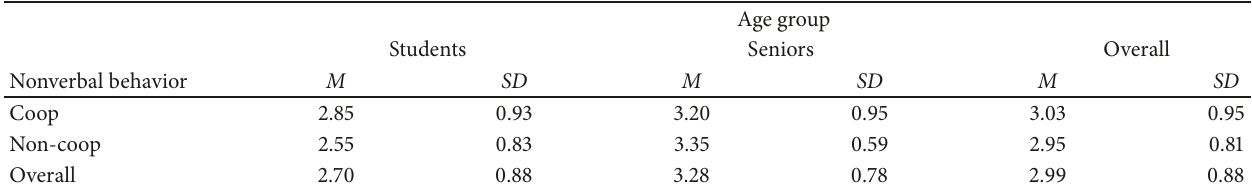
Table 2: Means for participants overall decision to cooperate.